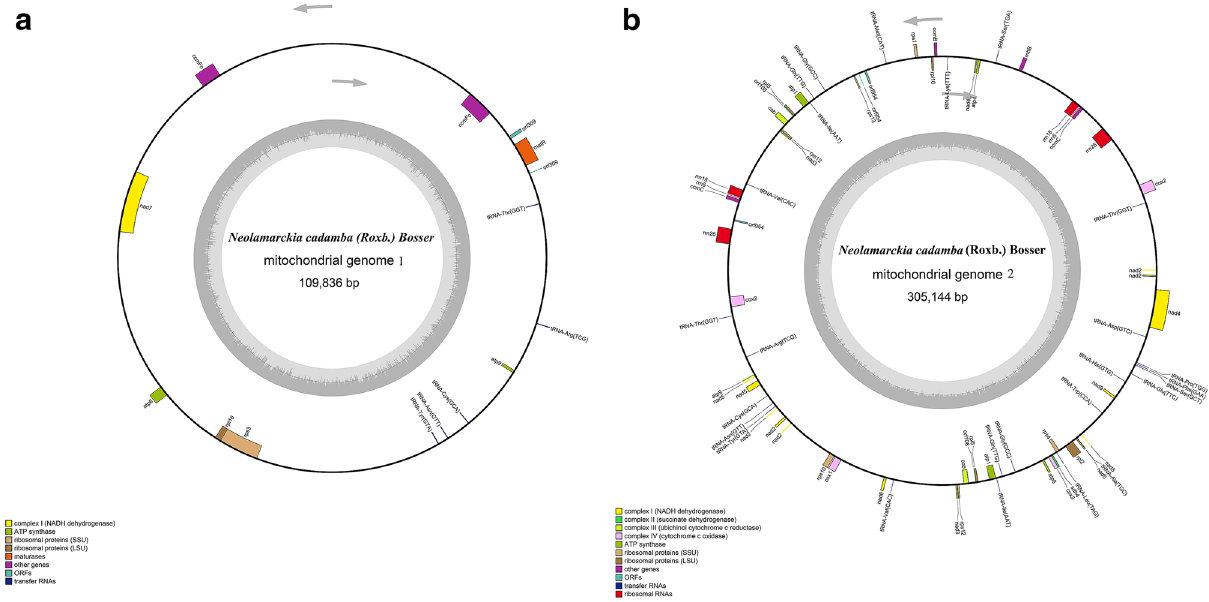
Figure 1. Two circular maps of the mitochondrial genome of Neolamarckia